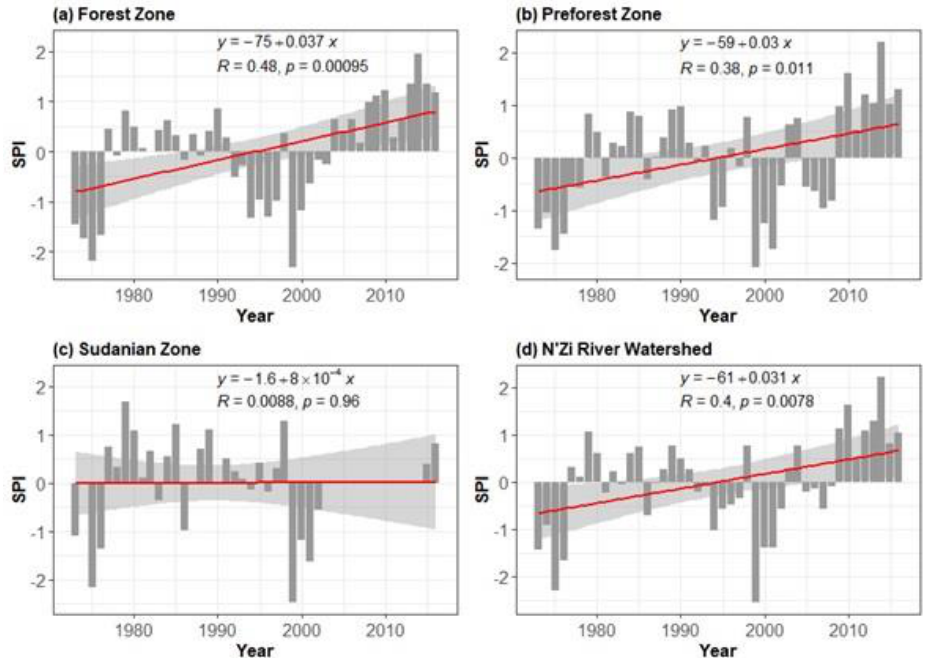
Fig. 4. Annual variation of the Standardized Precipitation Index (SPI) in the three different ecoregions of the NRW in central Côte d’Ivoire